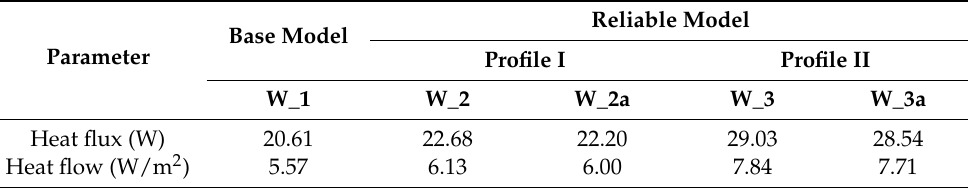
Table 5. Summary of the results of the numerical analysis for the slab-on-ground structure.